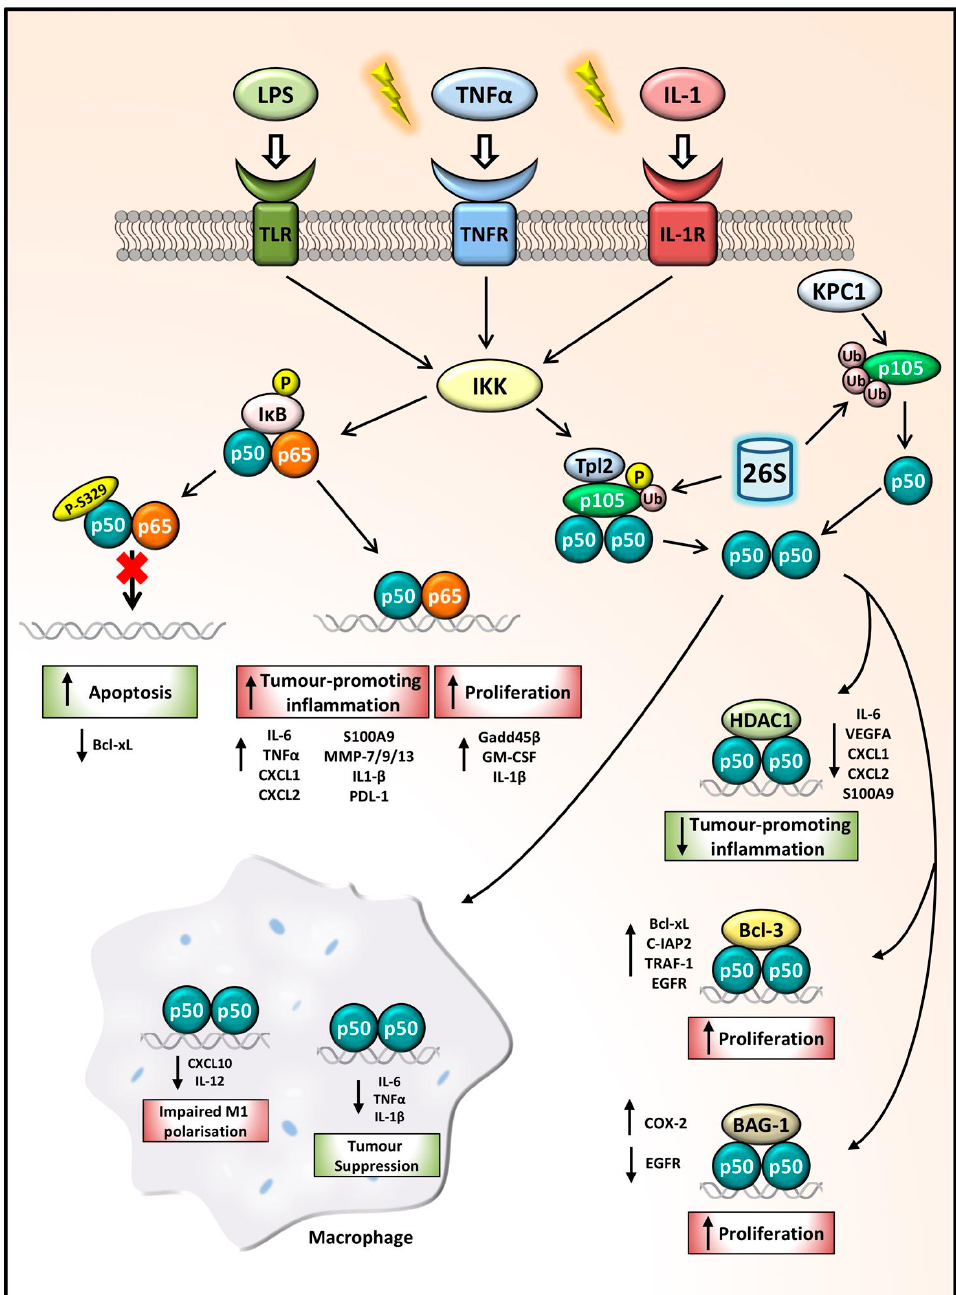
Figure 2. NFKB1 p105/p50 regulation of gene expression in cancer. Following inflammatory stimulation, IKK functions as the key activator of the NFKB1 signalling pathway. Phosphorylation and ubiquitination of I κ B releases p50:p65 dimers which can drive the transcription of tumour-promoting inflammatory genes and anti-apoptotic and proliferative genes. p50 phosphorylation at the S329 site impairs p50:p65 dimer binding to DNA, decreasing Bcl-xL expression leading to increased apoptosis, hindering cancer progression. p105 phosphorylation and ubiquitination leads to its processing by the 26S proteasome, releasing p50 homodimers. The p50:p50:HDAC1 complex represses tumour-promoting inflammatory gene expression thus acting as a tumour-suppressor complex, while p50 homodimers in complex with Bcl-3 or BAG-1 can drive proliferation. In macrophages, aberrant p50 homodimer repression of CXCL10 and IL-12 leads to impaired M1 polarisation. Whilst p50:p50 repression of pro-inflammatory and proliferative mediators can also promote tumour